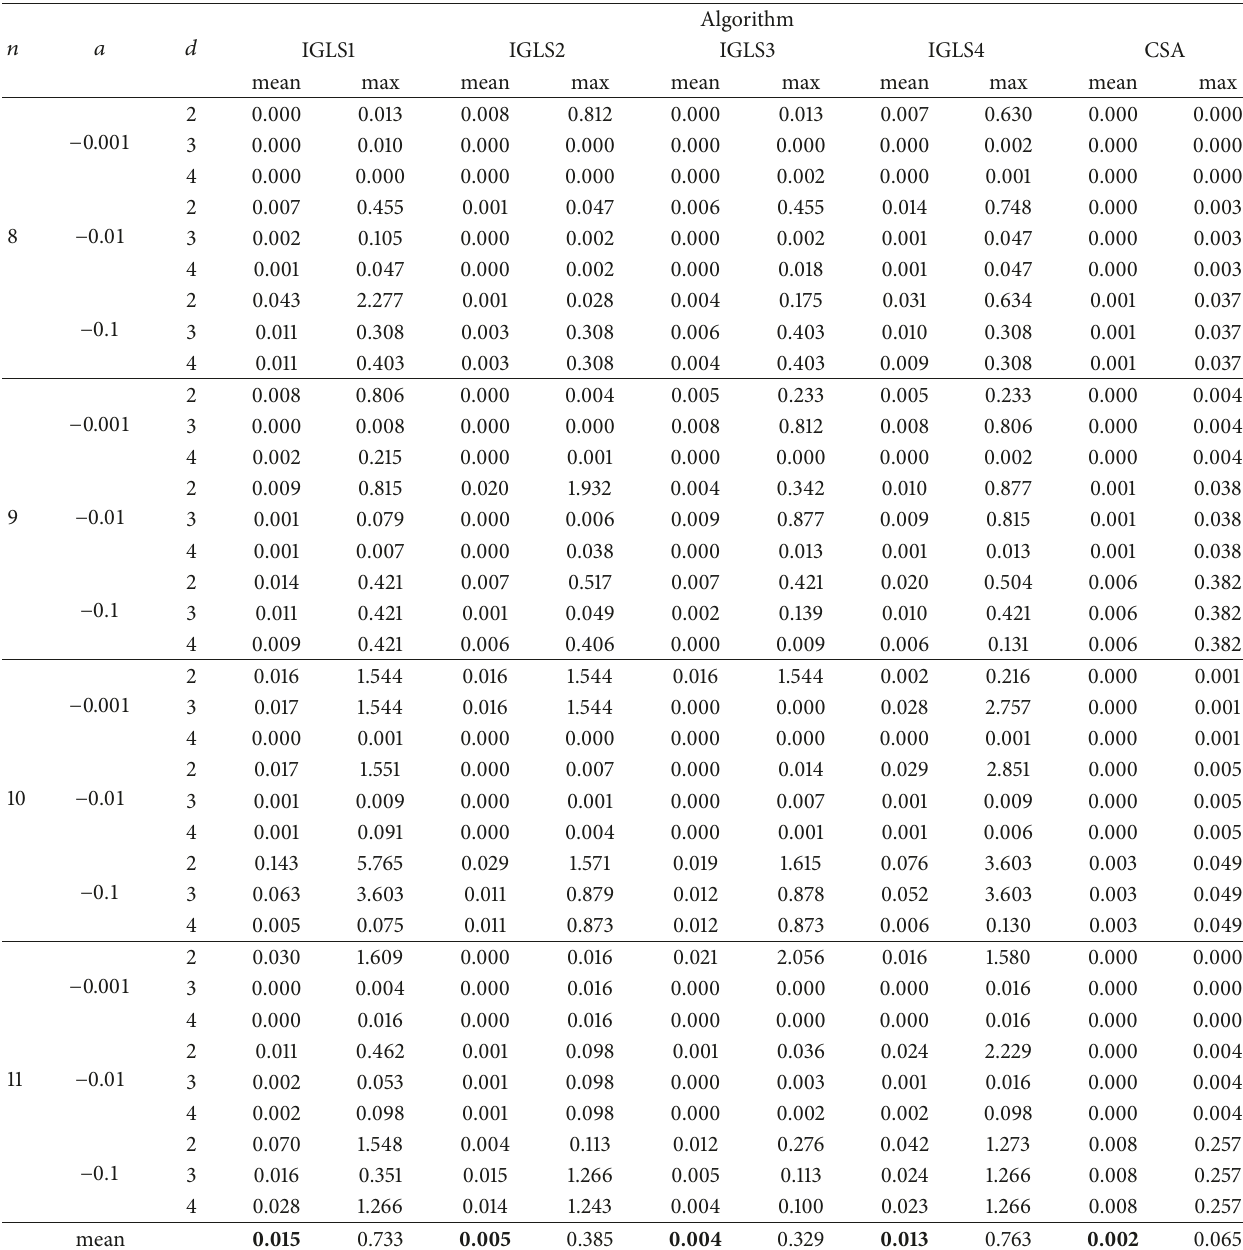
Table 2: The AEP of algorithms for small number of jobs.